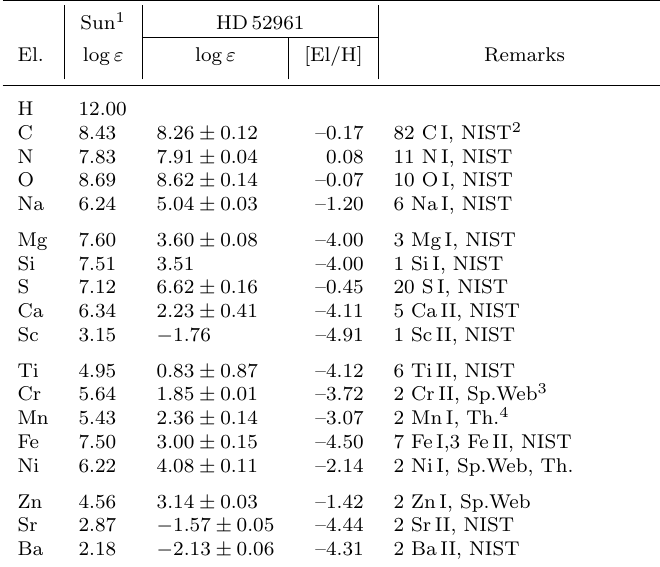
Table 2. Chemical composition of HD 52961. In Remarks the number of the used lines and the sources of oscillator strengths are indicated. Sun